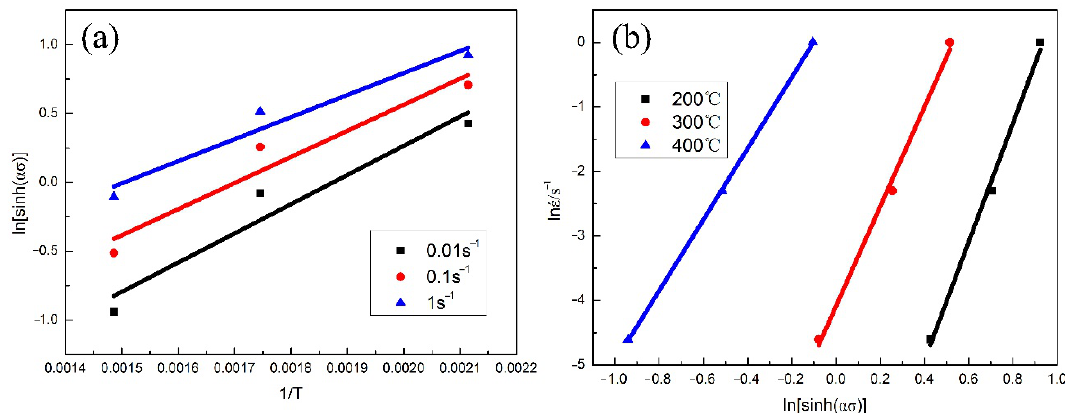
Figure 4. The linear relationship fitting at peak stress: ( a ) ln[sinh (ασ)] − 1/T and ( b ) ln έ − ln[sinh (ασ)]. Taking the natural logarithm on both sides of Equation (7) gives: According to Q-value, the Z-parameters at different deformation conditions can be obtained from Equation (10). The fitting the relationship between lnZ and ln[sinh(ασ)] is shown in Figure 5, and the regression analysis shows that lnA = 21.73 and n = 7.004. The correlation coefficient (R) value of the fitted line is 0.94, which represents that the hyperbolic sine model is adaptive for depicting the hot compression deformation behavior of this alloy.